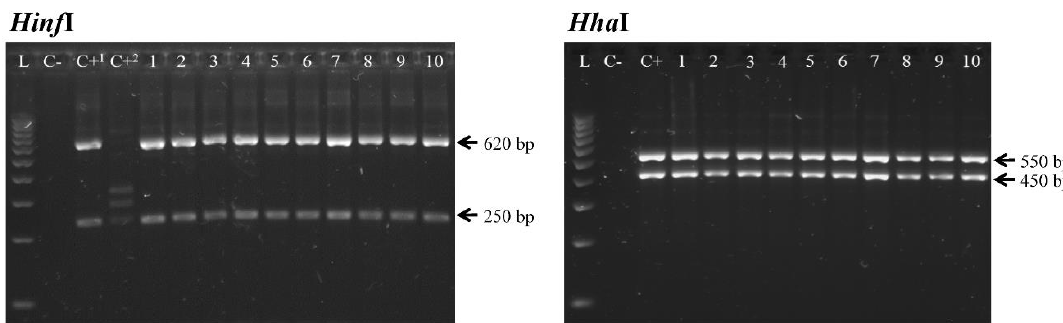
Figure 1. Restriction fragment length polymorphism (RFLP) patterns of Anisakis larvae recovered from the three patients. Hinf I and Hha I restriction enzymes of the internal transcribed spacer (ITS) region of the rDNA were used. L: 1000 bp ladder; C-: negative control; C+ 1 and C+: positive control of A. simplex (s.s.); C+ 2 : positive control of A. pegreffii ; lines 1-5: A. simplex (s.s.) from the first female patient; lines 6-9: A. simplex (s.s.) from the second female patient; line 10: A. simplex (s.s.) from the male patient.